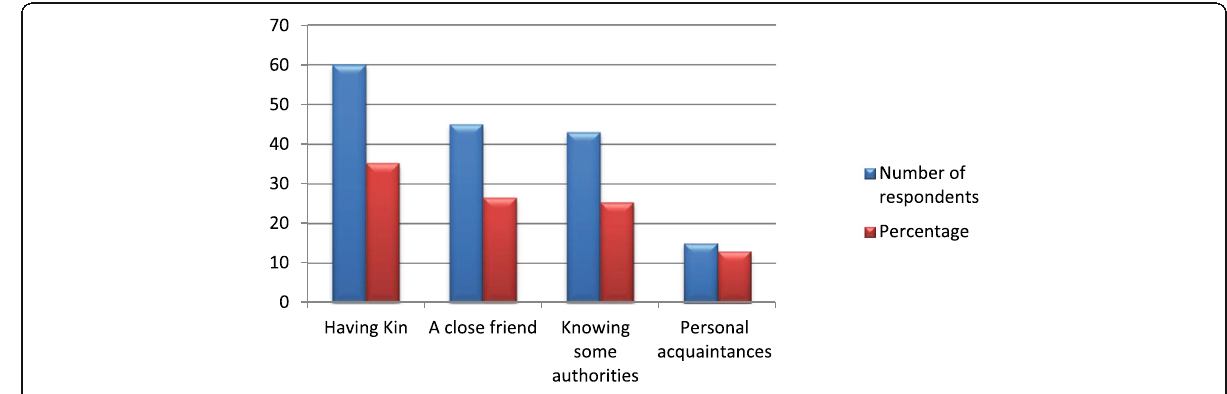
Fig. 2 Household ranking of vertical ties for safety net targeting (field